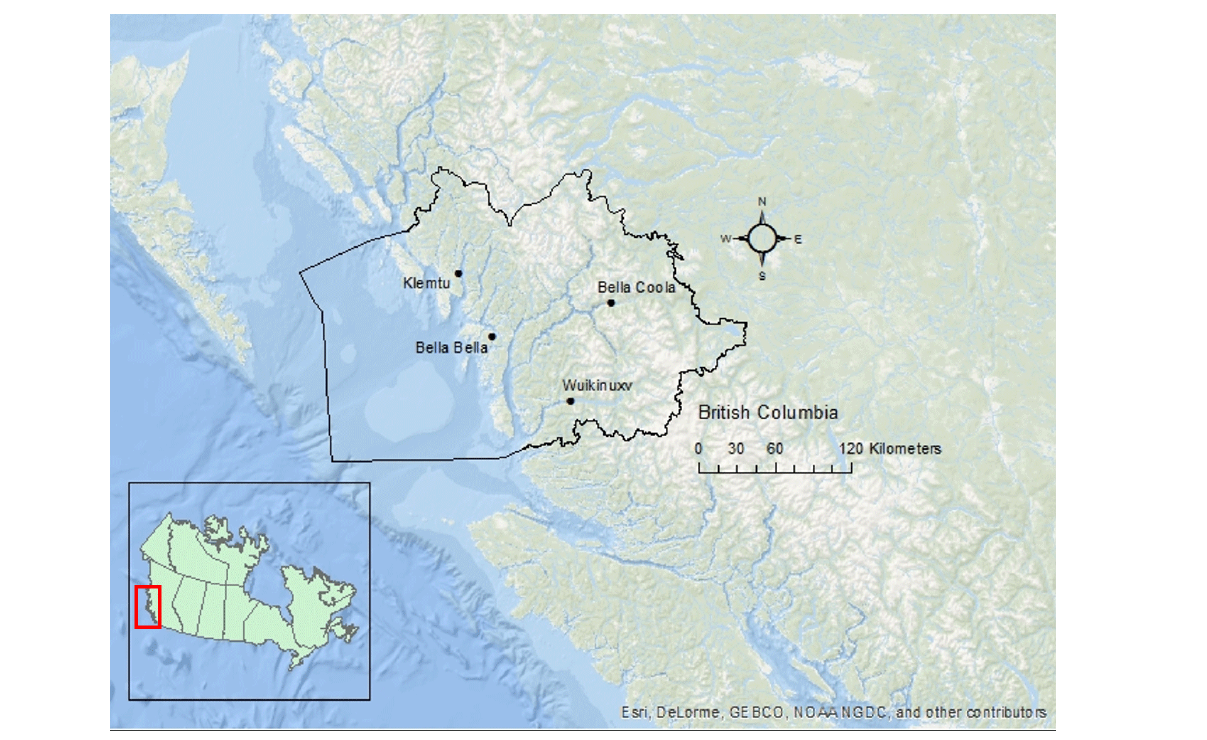
Fig. 1 . Map of study region. Bella Bella is home to the Heiltsuk Nation, Bella Coola to the Nuxalk Nation, Wuikinuxv to the Wuikinuxv Nation, and Klemtu to the Kitasoo/Xai’Xais Nation. The combined traditional territories of the four member Nations are